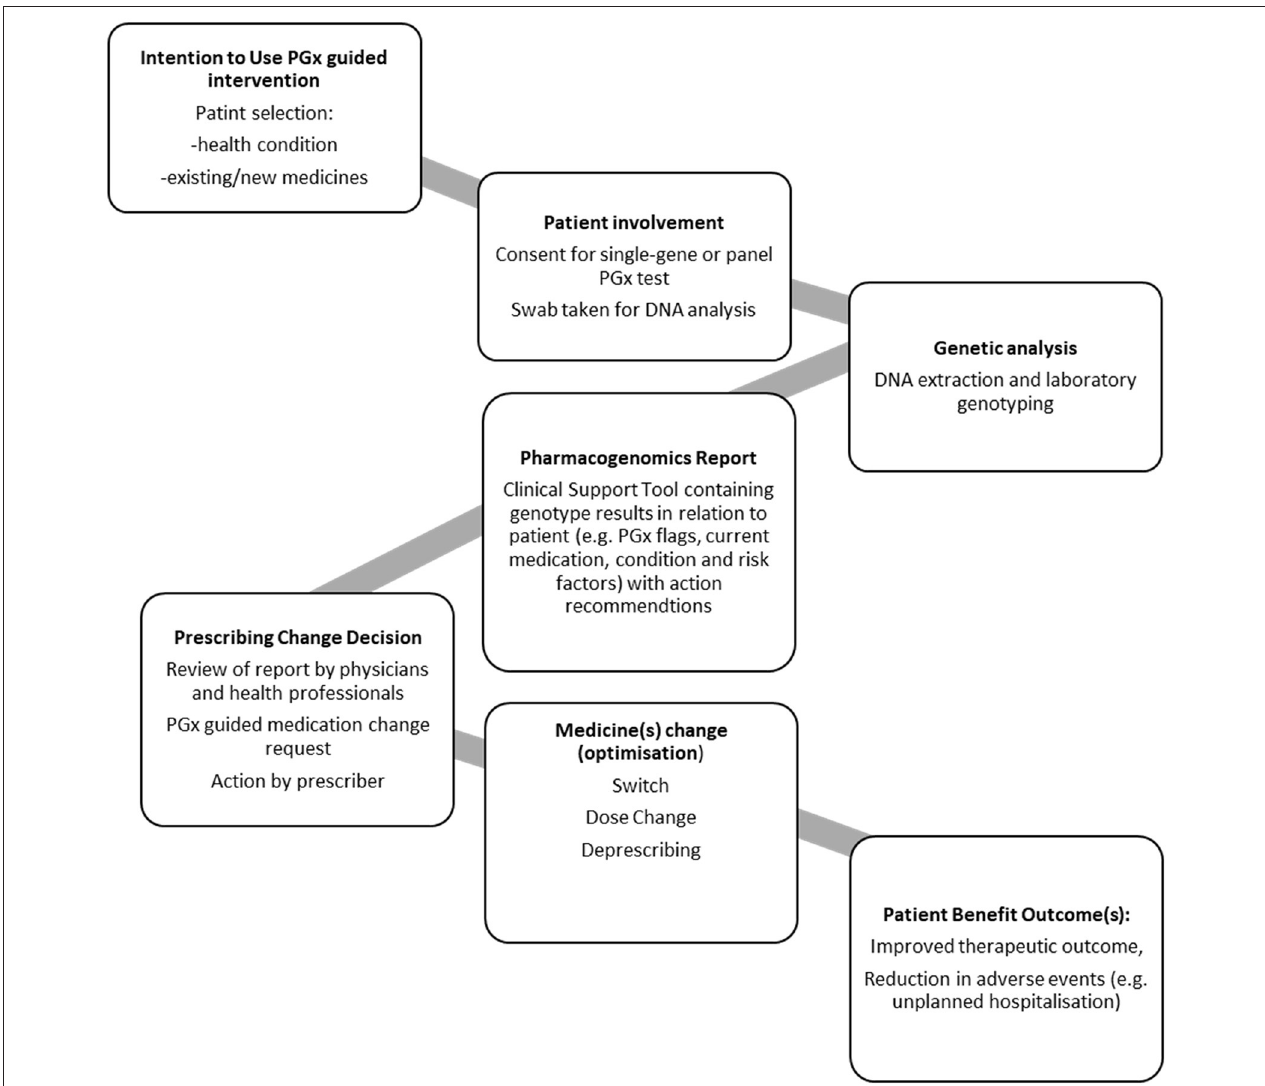
FIGURE 3 | PGx General process model for pharmacogenomic testing as an